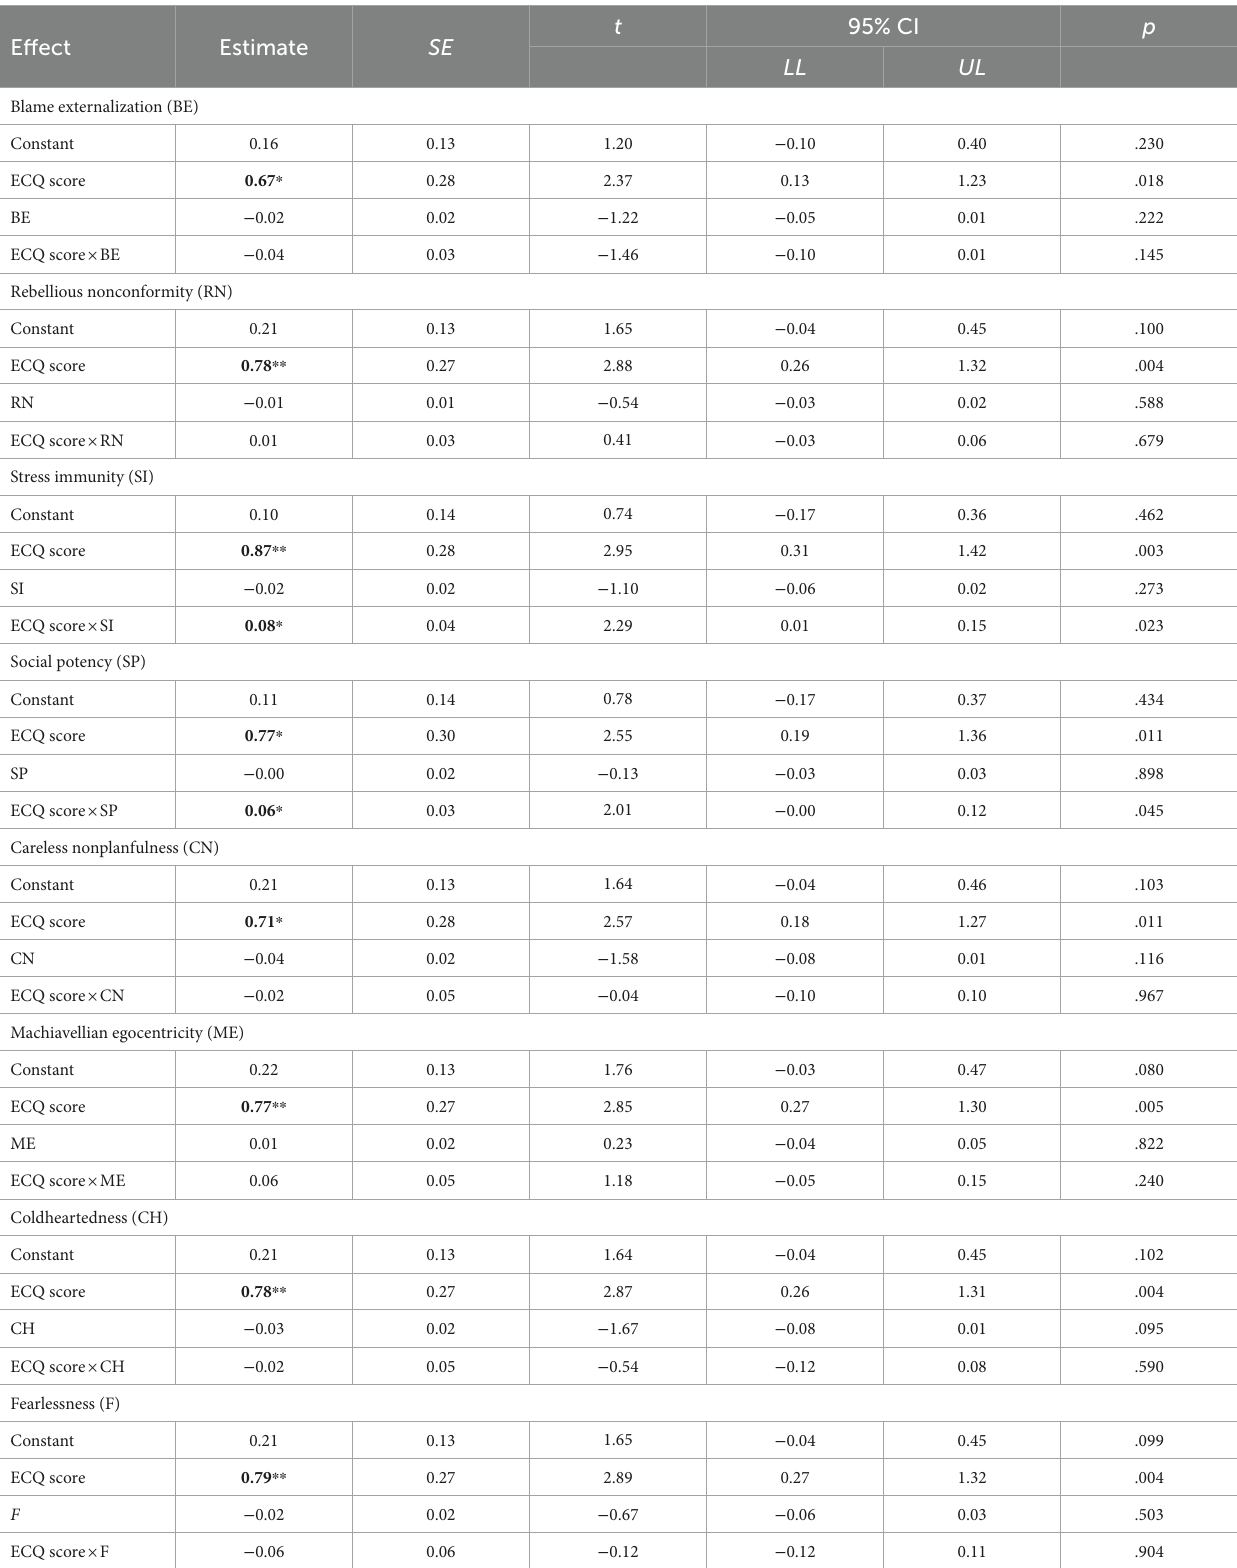
TABLE 5 Moderation analyses results for psychopathic personality traits scores moderating the relationship between emotional competence (ECQ Score) and cognitive composite score.